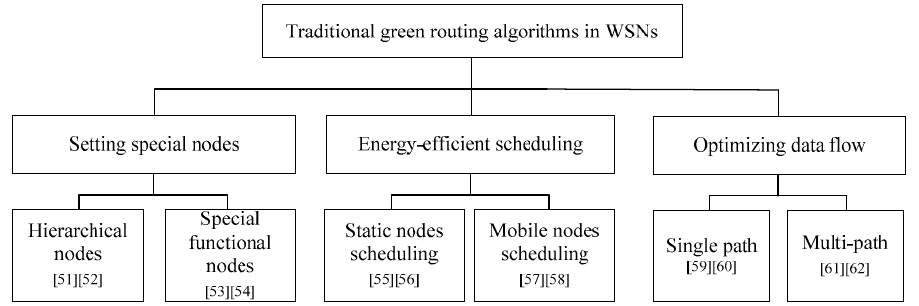
Figure 1. The classification of traditional green routing algorithms in WSNs.